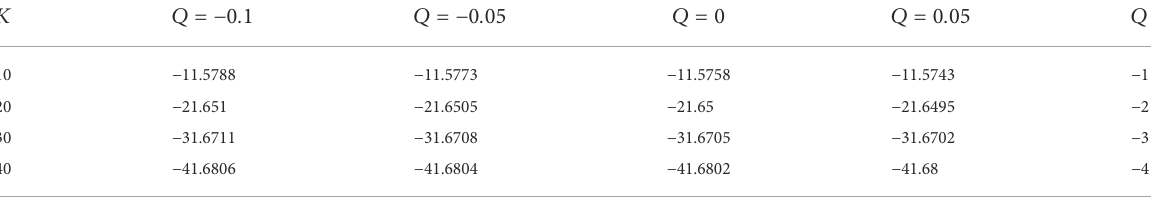
(cid:6)(cid:6) √ 2 /2 − 1.